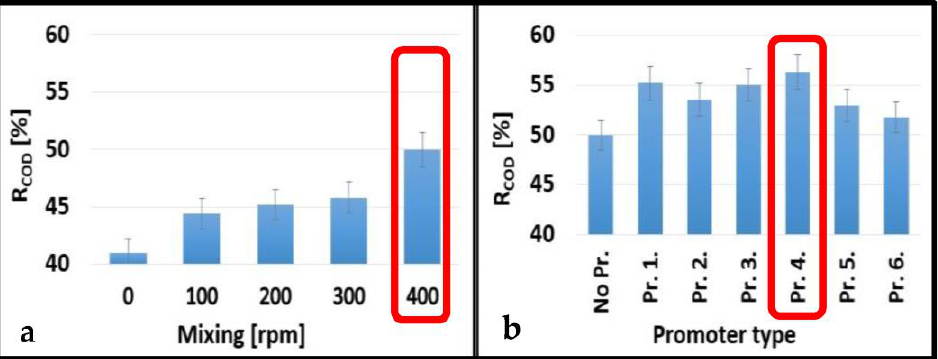
Figure 6. Effects of mixing speeds without 3DP turbulence promoters ( a ) and different promoters at 400 rpm mixing ( b ) on the average COD rejections for a 10 kDa NMWL UF membrane.